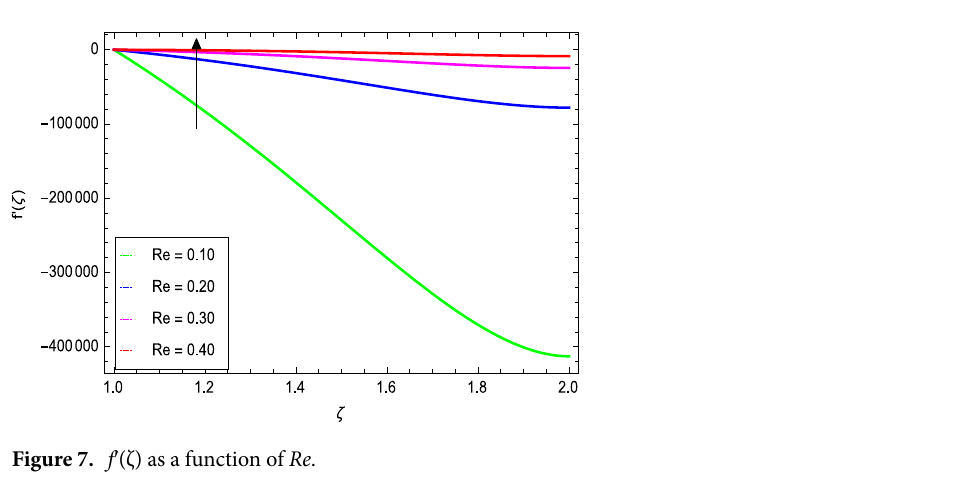
Figure 7. f ′ (ζ) as a function of Re